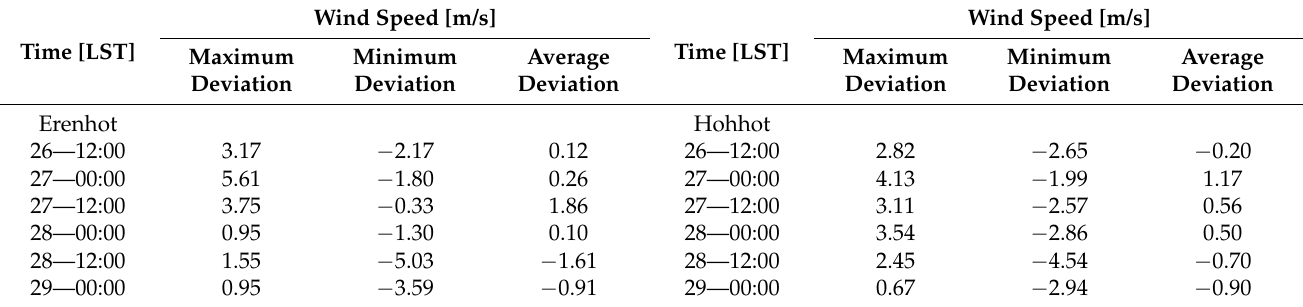
Table 4. Statistical biases of mean wind speed above the main landing area in the “Shen Zhou 7” case.